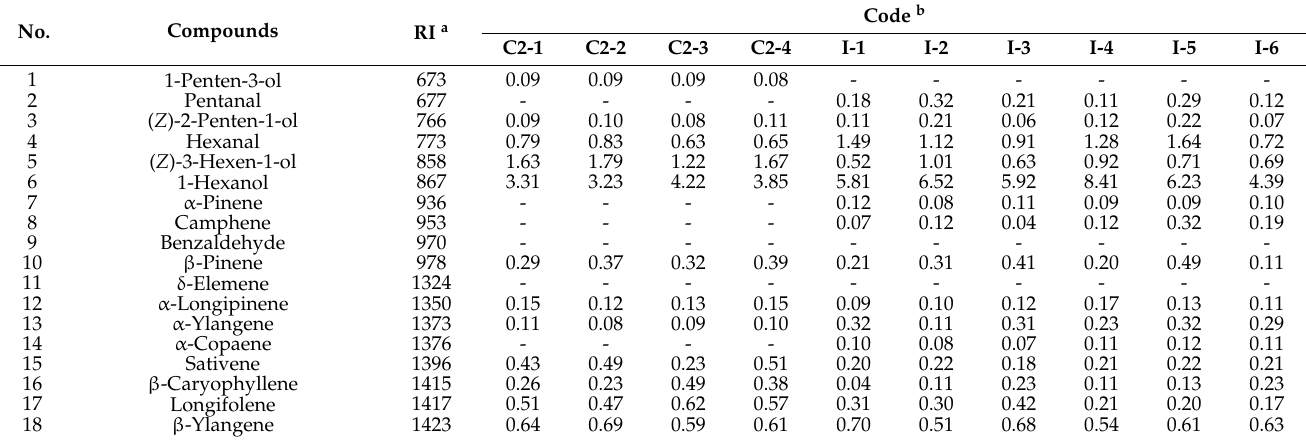
Table 3. Volatile compounds detected in the analyzed samples of genetic lineage C2 and cryptic species I of the A. pinguis.